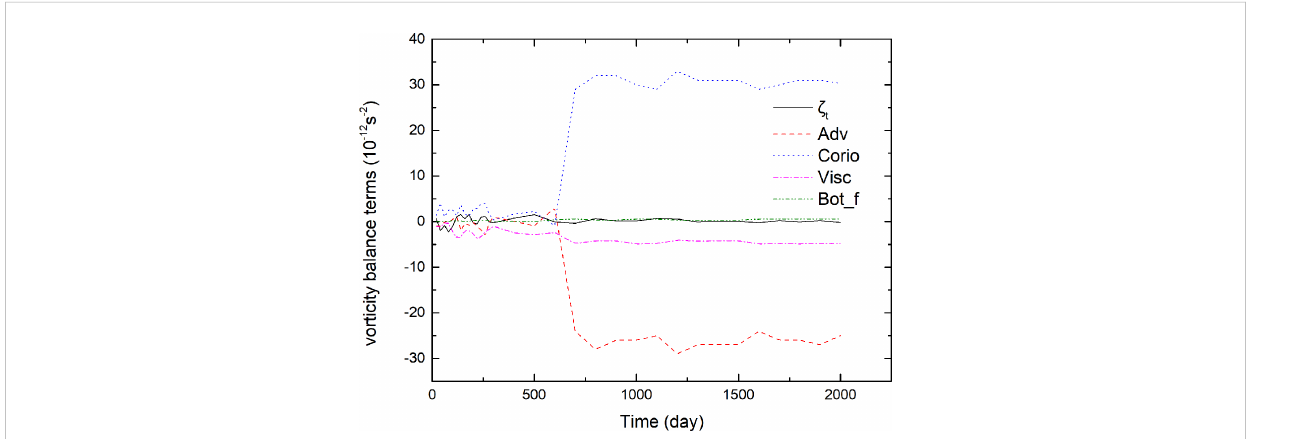
FIGURE 5 Time evolution of the vorticity balance terms near X P during the interaction of the anticyclonic eddy and the WBC critical from penetration to leap at Re = 76 in the vicinity of the gap with two islands. WBC, western boundary